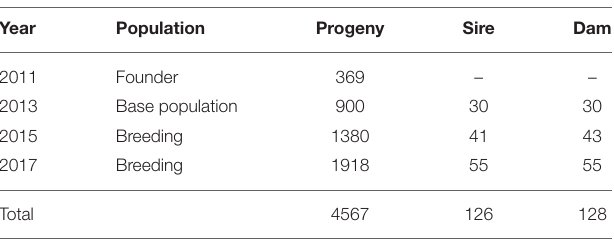
TABLE 2 | Number of progeny, sire, and dam in spawning